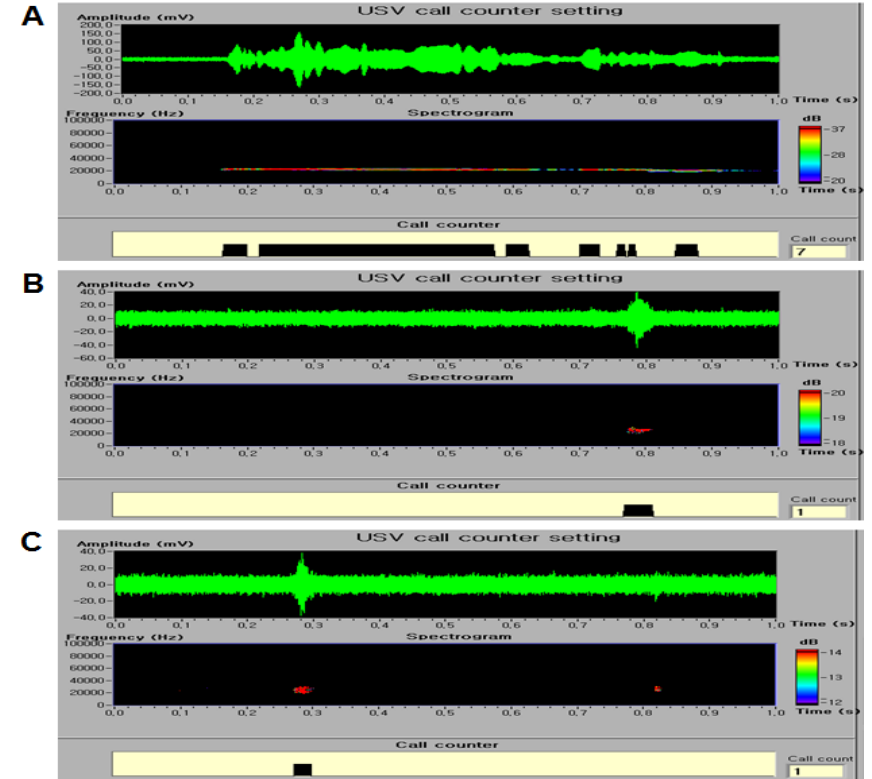
Figure 3. Effect of E. cava extracts on USVs induced by plantar incision in rats. The sonograms of USVs in ( A ) control, ( B ) gabapentin and ( C ) E. cava extracts treated rats. ( D ) A significant difference in 22–27 kHz USV calls was observed between the E. cava extracts treated group and the control group. Data are mean ± SEM (n = 7 per group). ** p < 0.01 and *** p < 0.001, significant difference from the control